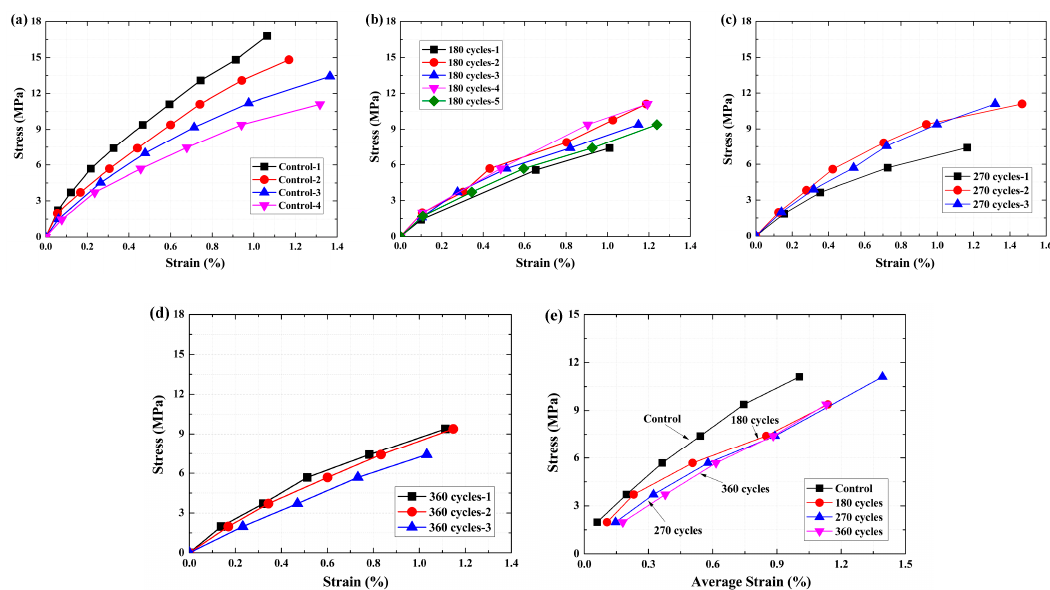
Figure 13. Mechanical properties of the epoxy resin matrix with increasing wet–dry cycles, ( a ) control; ( b ) 180 cycles; ( c ) 270 cycles; ( d ) 360 cycles; ( e ) average strain.